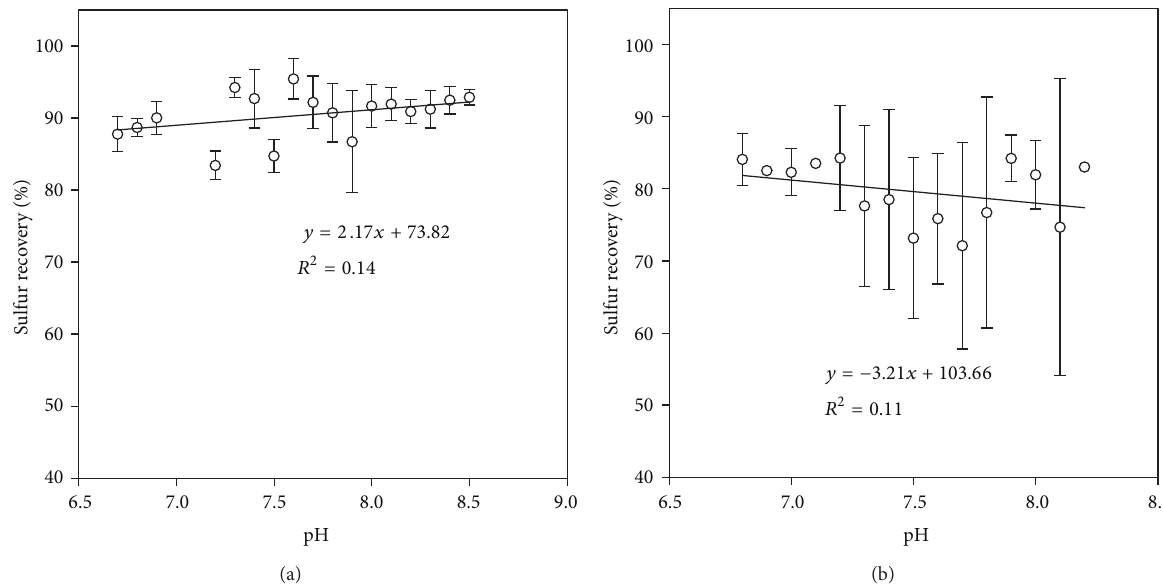
Figure 6: Effect of pH on bioconversion end product: (a) O 2 /H 2 S molar ratio < 10 and (b) O 2 /H 2 S molar ratio